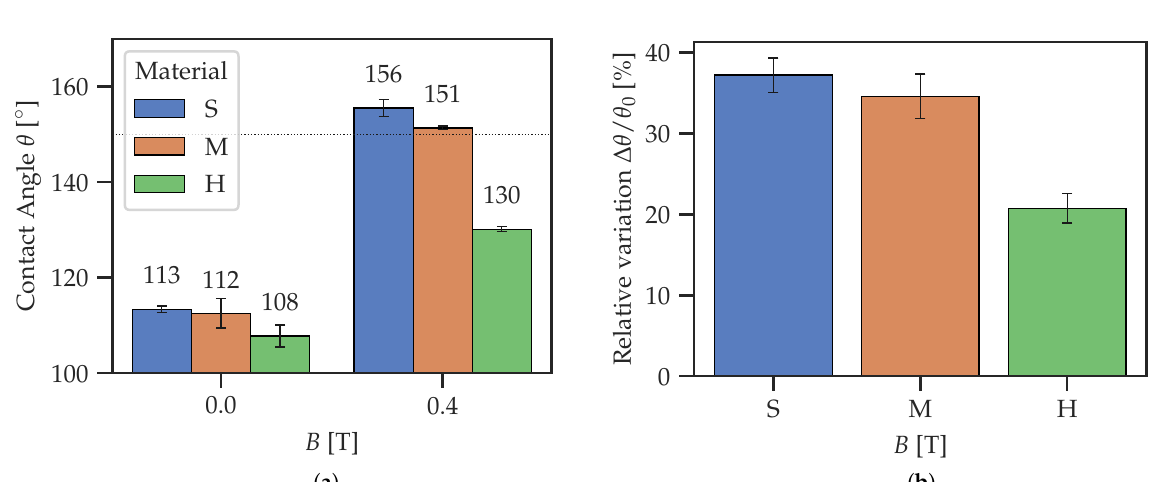
Figure 9. Comparison of magnetic field effects for MAE films of different stiffnesses. ( a ) Switching of CA with magnetic field. ( b ) Relative magnetic field-induced variation of